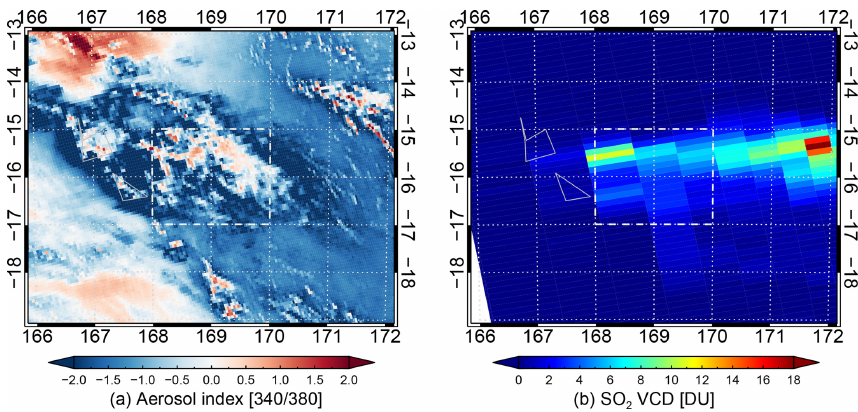
Figure 6. (a) TROPOMI UV aerosol index (340/380nm) from the operational Level 2 product and (b) OMI SO 2 vertical columns (DU) from the column amount SO 2 TRM (mid-troposphere) of the operational OMSO2 product for a volcanic BrO measurement scenario. The domain used for the sensitivity test is indicated by a gray dashed box.